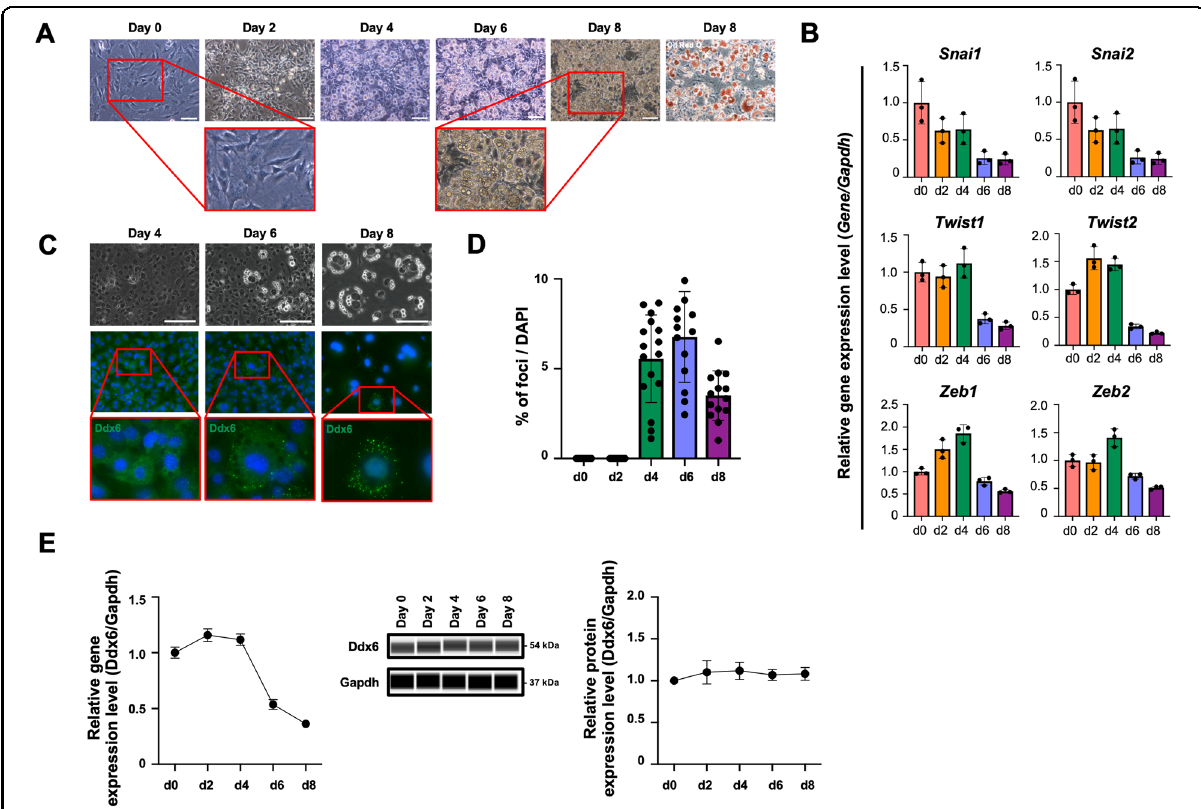
Fig. 1 Adipogenic differentiation of 3T3L1 preadipocytes. A Phase-contrast microscopy images during adipogenesis. 3T3L1 preadipocytes were differentiated into adipocytes using an adipogenic differentiation cocktail containing dexamethasone, IBMX, and insulin. On day 8, the cells were fi xed and stained with oil red O. The scale bar is 100 μ m. B RT-qPCR analysis of gene expression in 3T3L1 preadipocytes during adipogenesis. Individual RNA expression levels were normalized to Gapdh expression levels. The error bars indicate the SDs ( n = 3). C Immunocytochemistry images during adipogenesis. Formation of Ddx6 foci was observed. The scale bar is 50 μ m. Nuclei were stained with DAPI. D Ratio of the number of cells with Ddx6 foci to the number of DAPI-positive cells each day following adipogenic induction analyzed in three sessions. Independent researchers chose 7 – 5 microscopic fi elds in a session at random. E Protein ( n = 4) and gene ( n = 6) expression analysis of Ddx6 during adipogenesis. The error bars indicate the